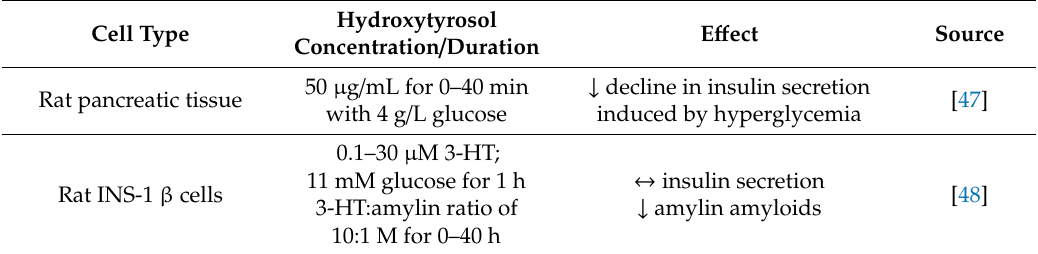
Table 6. E ff ects of hydroxytyrosol on pancreatic